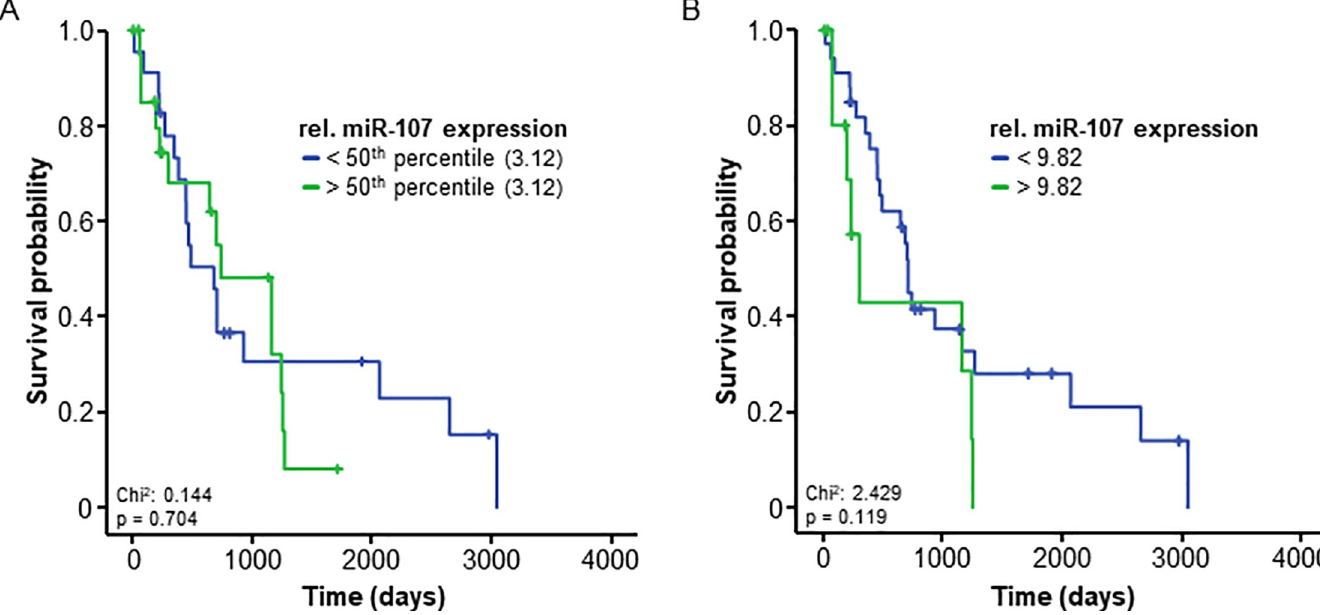
Fig 4. Serum levels of circulating miR-107 are unsuitable to predict outcome in early-stage HCC patients. (A) HCC patients with miR-107 serum levels above or below the 50 th percentile (3.12) have a comparable overall survival. (B) HCC patients with miR-107 serum levels above the ideal prognostic cut-off value (9.82) show a non-significant trend (p = 0.119) towards an impaired